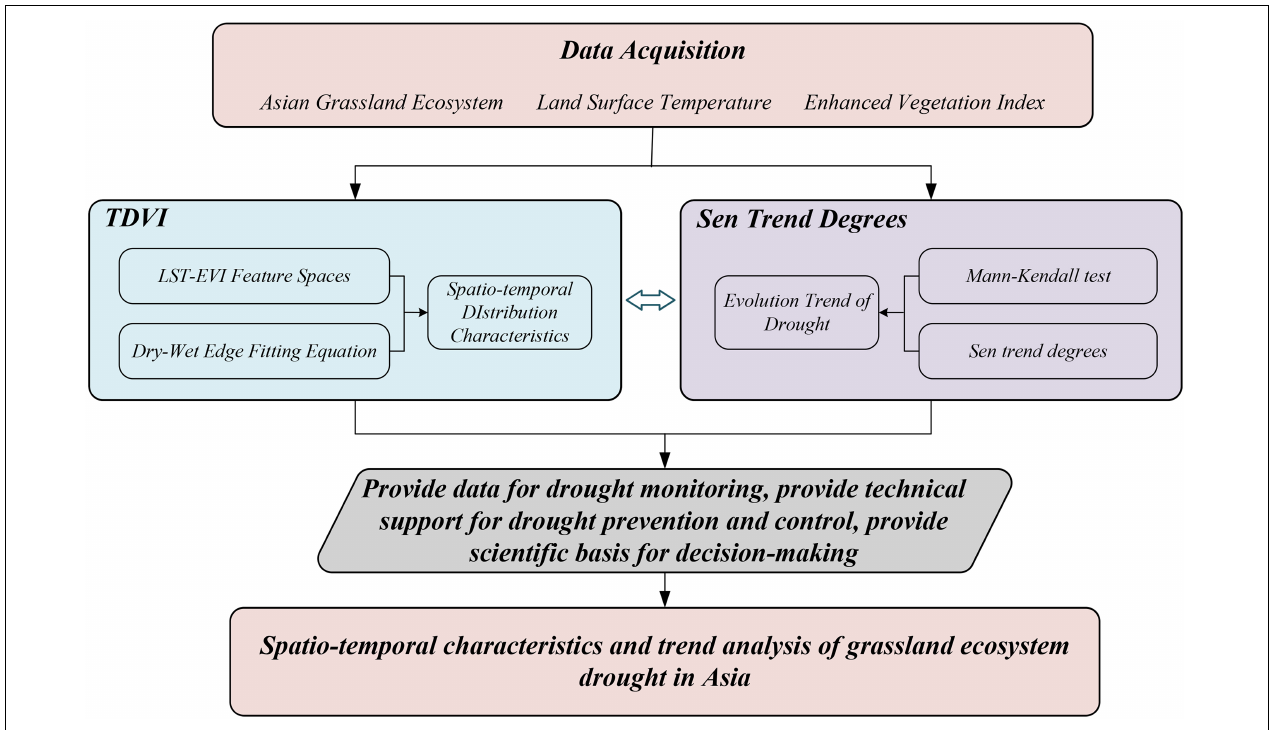
FIGURE 2 | Research technology